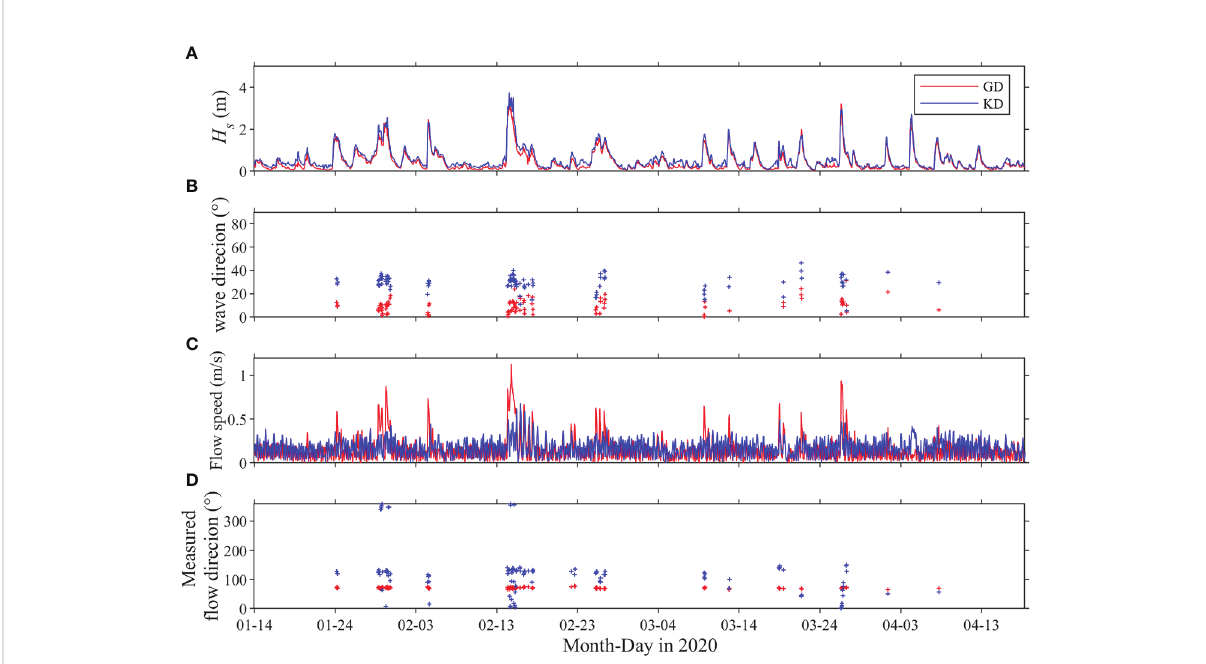
FIGURE 10 Time series of (A) signi fi cant wave height Hs , (B) wave direction, (C) fl ow speed, (D) fl ow direction. Red and blue represent GD and KD,